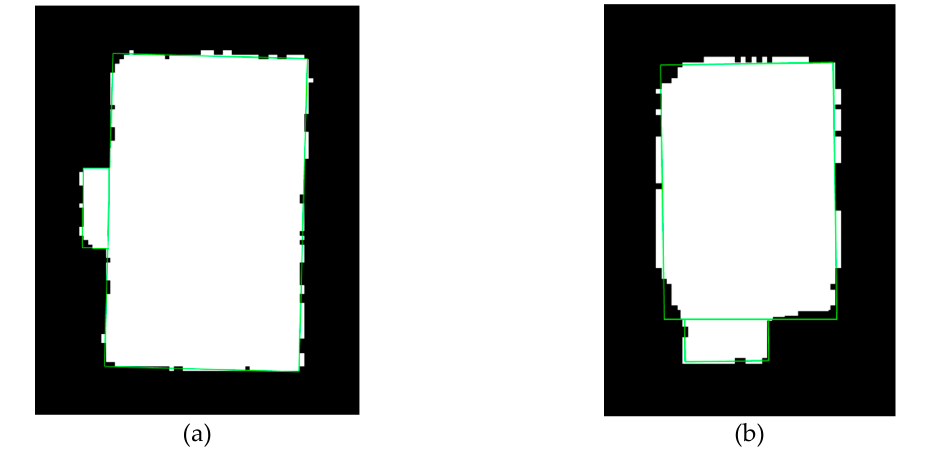
Figure 9. Fitting rectangles on building regions by green color using the firefly algorithm. ( a ) First simulated rectangle and ( b ) second simulated rectangle.